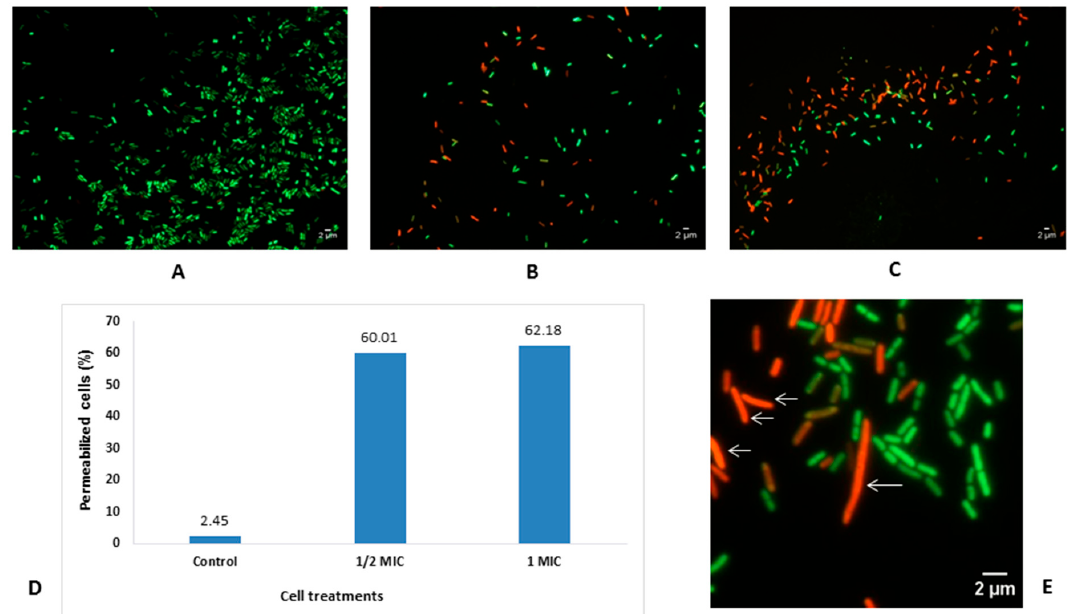
Figure 4. Effects of L. cubeba fruit EO on the viability of E. coli ATCC 25922. Fluorescence microscopic images with the LIVE / DEAD Baclight kit of E. coli cells after 2 h of exposure to the EO. Control: EO-untreated cells ( A ); EO-treated cells at 0.5 MIC ( B ) and at 1 MIC ( C ), and proportion of permeabilized cells ( D ). Viable cells are indicated by green fluorescence, whereas cells with damaged membranes are indicated by red fluorescence. The white arrows indicate elongated cells ( E ) and the filament cells were > 6 µ m in length. Scale bar represents 2 µ